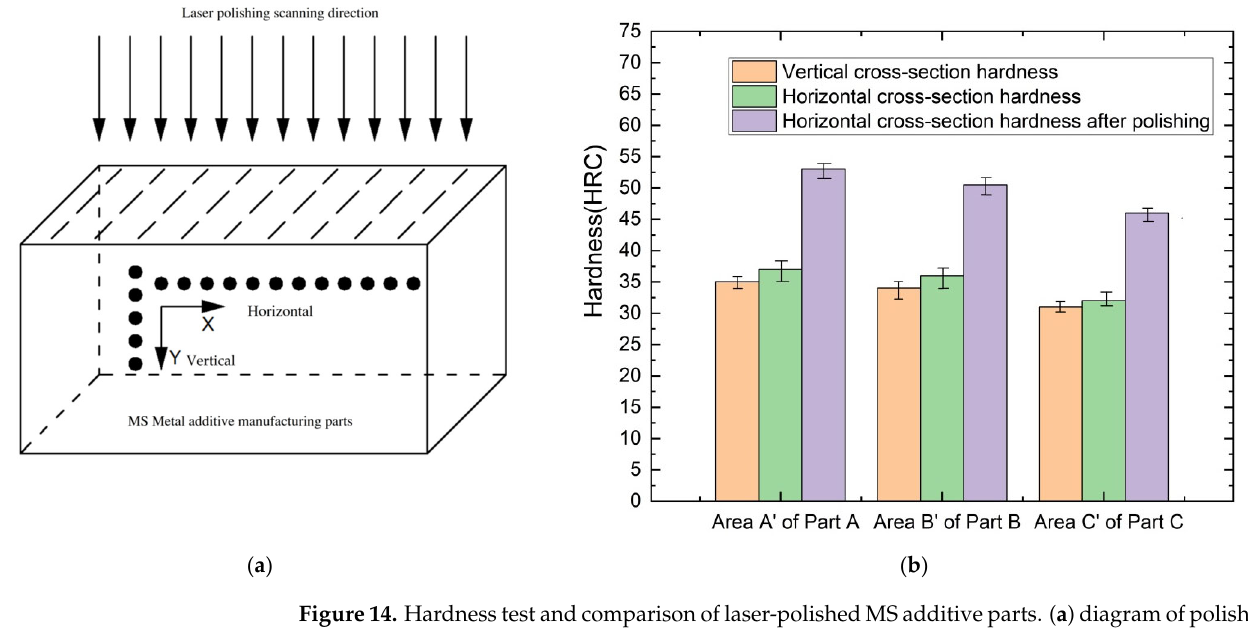
Figure 14. Hardness test and comparison of laser ‐ polished MS additive parts. ( a ) diagram of polishing hardness test; ( b ) hardness of the as ‐ fabricated and polished MS parts.